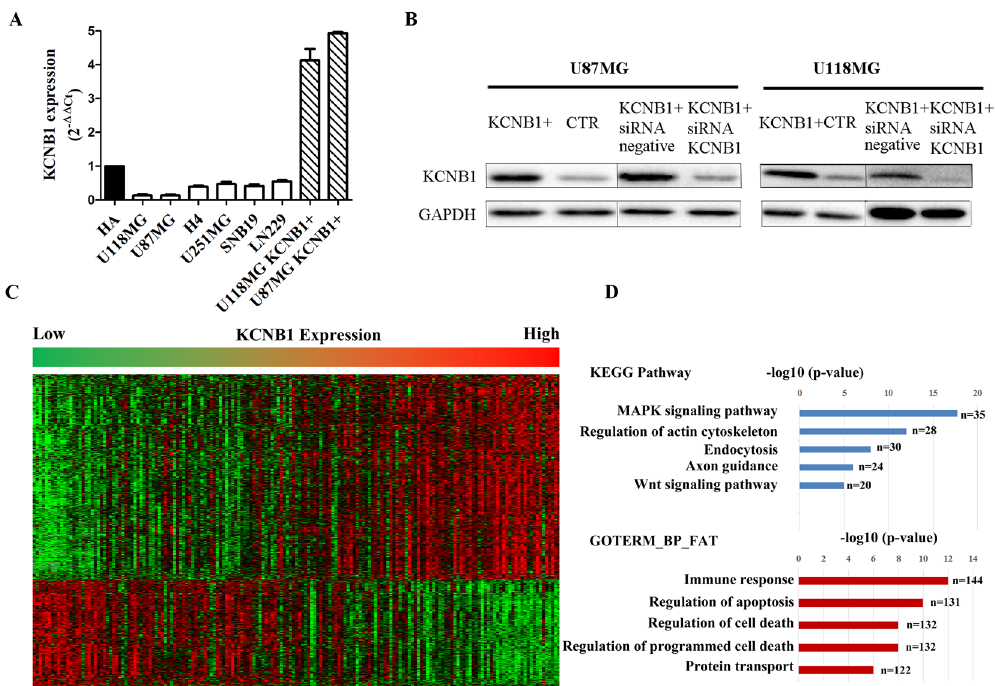
Figure 2. KCNB1 mRNA and protein expression in glioma cells and Clustering analysis of whole transcriptome sequencing from CGGA. ( A ) KCNB1 mRNA expression in glioma cells (vs. normal human Astrocytes cells HA) and cells transduced with the KCNB1 vector (KCNB1 + ). ( B ) Western blot of KCNB1 + cells. ( C ) Patterns of whole transcriptome sequencing were associated with KCNB1 in gliomas using one-dimensional hierarchical clustering analysis. ( D ) Functional enrichment analysis of associated genes, indicating the functional roles of gene sets in different subgroups. Enrichment results for biological processes were obtained from the GO and KEGG Pathway